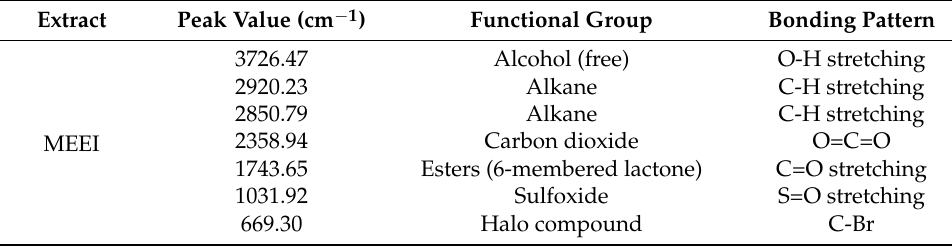
Table 2. Functional groups and bonding patterns in the methanolic, ethanolic, and hexane extracts of Enteromorpha intestinalis as determined by FT-IR